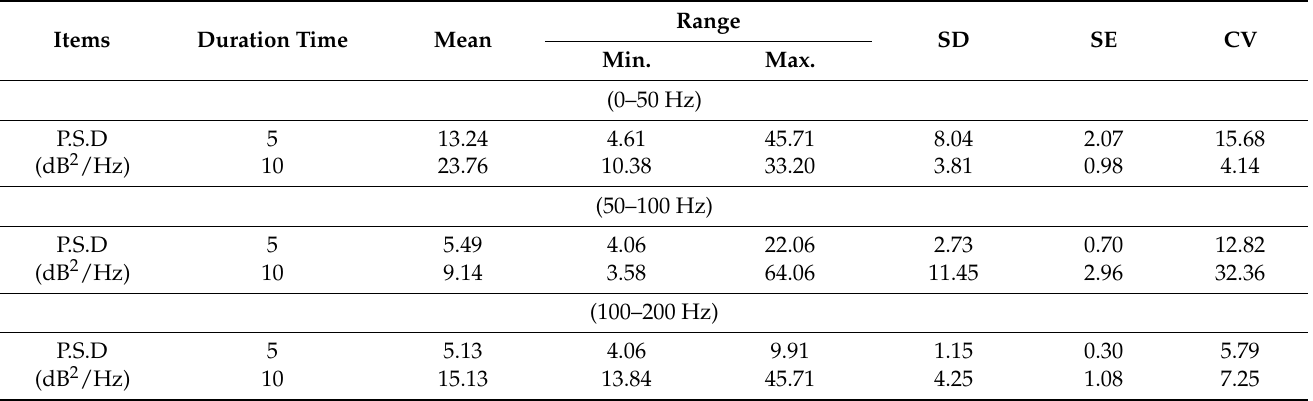
Table 2. Descriptive statistics of vibration analysis for cantaloupes in paper pulp tray packaging at different frequencies.